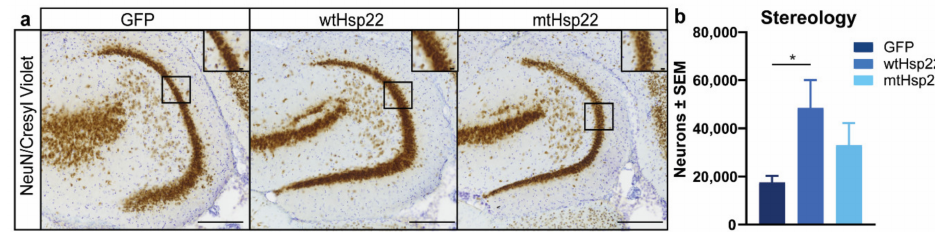
Figure 5. Hsp22 overexpression protects neurons in rTg4510 mice. ( a ) Immunohistochemistry staining and ( b ) quantification of neurons (NeuN/Cresyl violet) in the hippocampi of rTg4510 mice injected with GFP ( n = 6), wtHsp22 ( n = 6), or mtHsp22 ( n = 6) (mean ± SEM; scale bar represents 200 µ m; inset represents 10 µ m). * p <